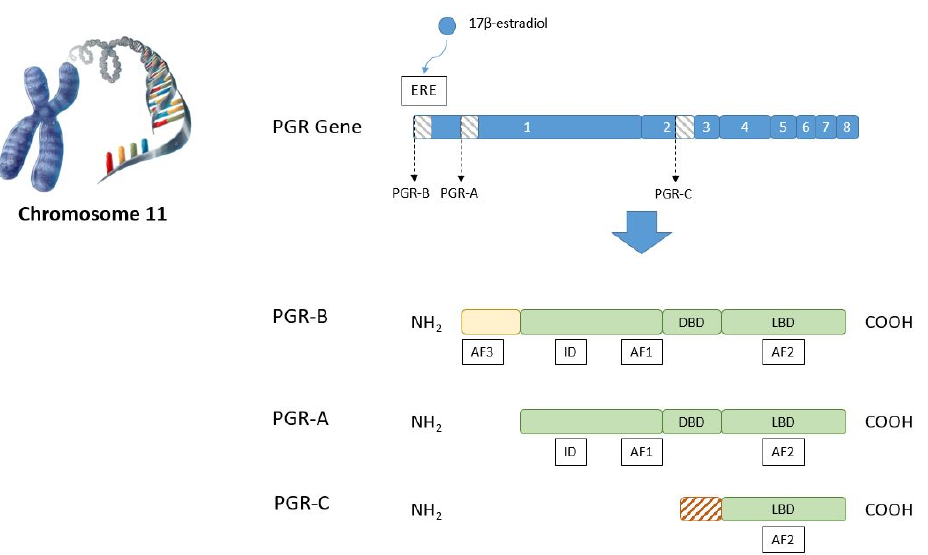
Figure 1. Representation of the classical PGR gene found in chromosome 11, and as of the protein domains of PGR isoforms A, B, and C. In response to estrogen binding to ERE, the PGR gene codifies for the distinct isoforms by the influence of different promoters. ERE = estrogen response elements. AF = activation function domain. ID = inhibitory domain. DBD = DNA-binding domain. LBD = ligand-binding domain. NH 2 = amino terminal region. COOH = carboxyl terminal region.